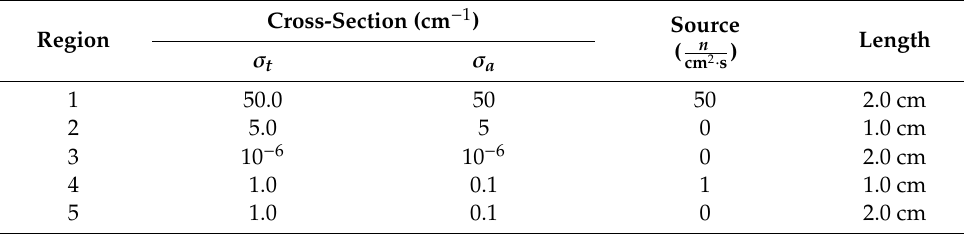
Table 1. Cross-sections and source of Reed’s edge cell